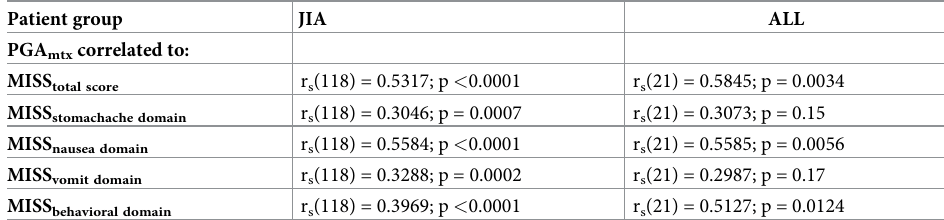
The correlations between the physician’s global assessment of the patients’ current level of methotrexate intolerance (PGA mtx ) and the methotrexate intolerance severity score (MISS)–the total score and the scores for the four domains–for the juvenile idiopathic arthritis (JIA) group (n = 120) and the acute lymphoblastic leukemia (ALL) group (n = 23). r s ; Spearman’s Rho (degrees of